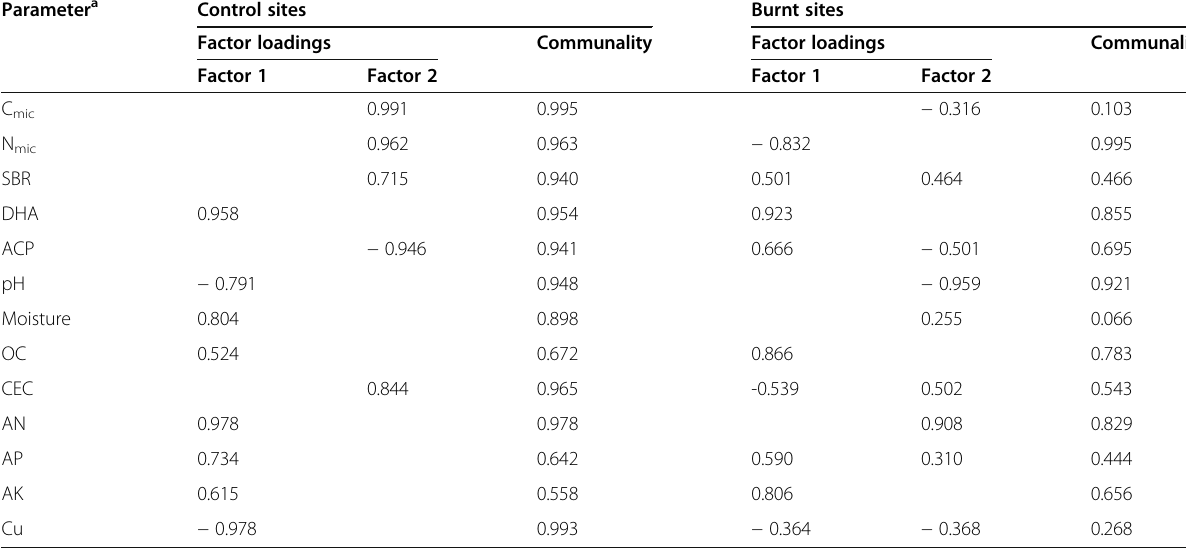
Table 3 Factor analysis for the control and burnt sites for the measured soil parameters Parameter a Control sites Burnt sites Factor loadings Communality Factor